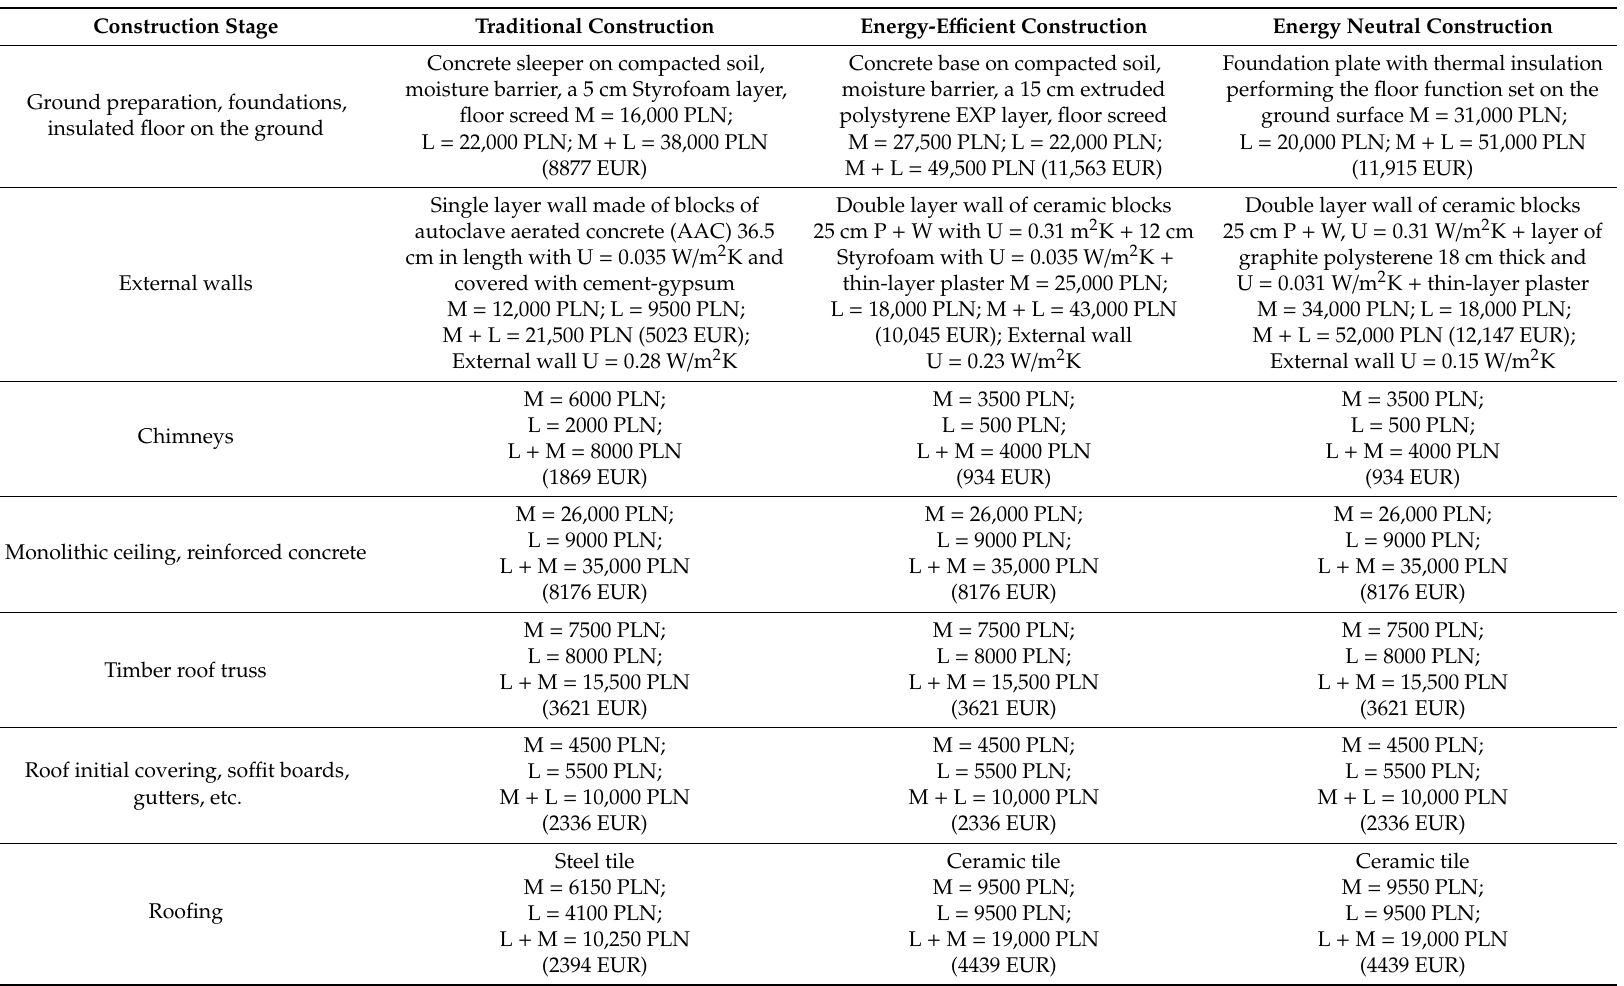
Table 1. Building stage and costs of materials and labor for three construction technologies applying di ff erent thermal insulation and heating and supplementary energy supply systems for a single-family home with 100 m 2 of living space, Poland,